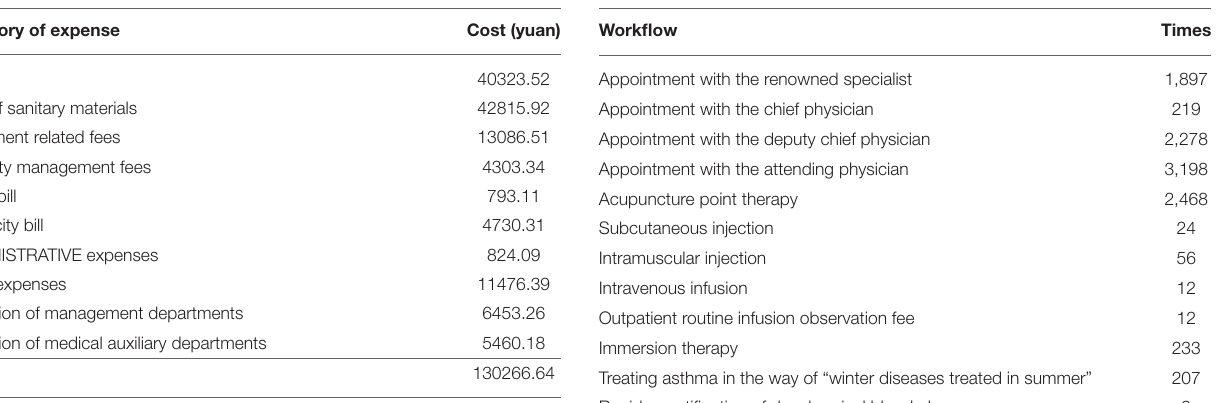
TABLE 3 | Total cost of outpatient department of Traditional Chinese